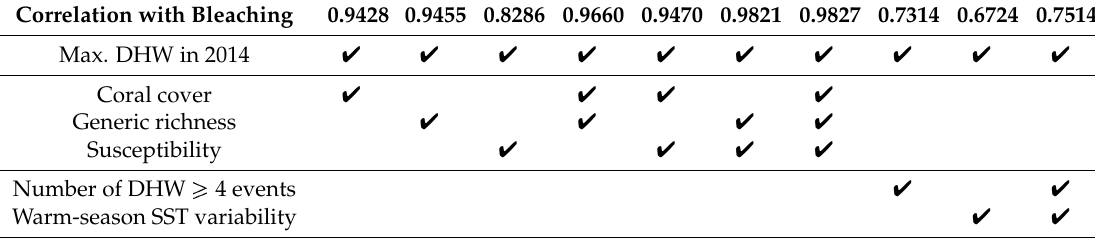
Table 3. Multiple correlations between bleaching (dependent variable) and combinations of location-specific